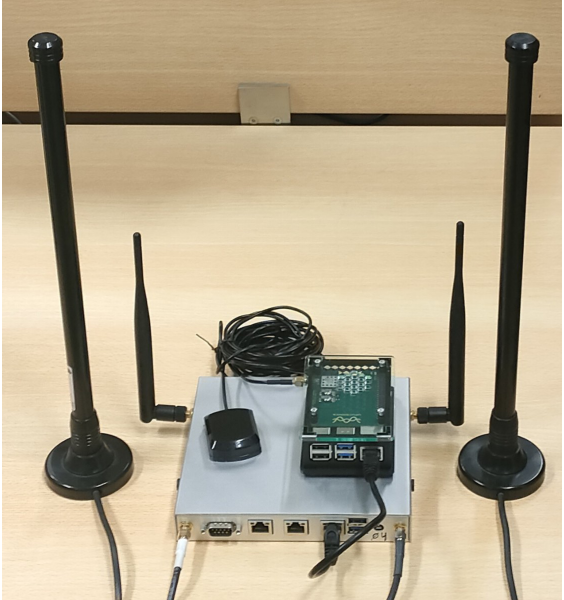
Figure 8. An RSU used for performance analysis of the proposed implemented system. It is connected via Ethernet to a Raspberry Pi which functions as a timeserver. The pair of larger antennas are used for ITS-G5 communications, while the pair of smaller antennas are used for LTE